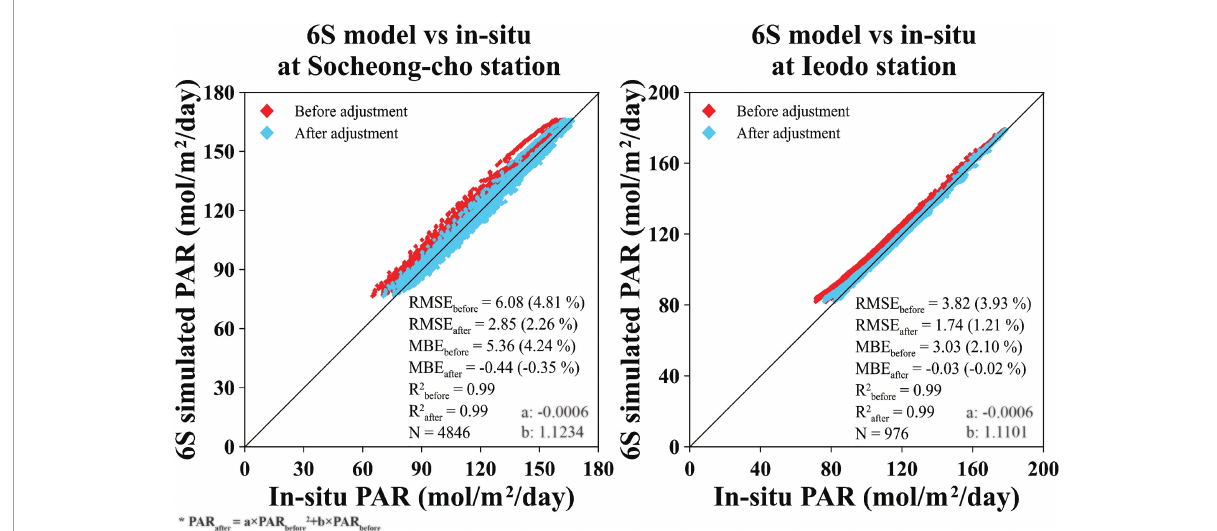
FIGURE 3 Comparison of in situ instantaneous PAR ( in situ iPAR) and 6S model-based instantaneous PAR (6S iPAR). To minimize aerosol effects, we used only data obtained under clear skies and at low solar zenith angles